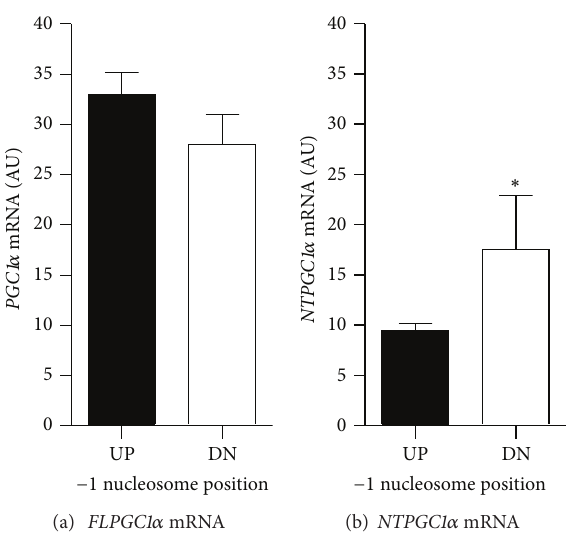
Figure 2: PGC1 𝛼 gene expression. mRNA expression of FLPGC1 𝛼 (a) and NTPGC1 𝛼 (b) was measured by qRT-PCR in quadriceps muscle samples and mean ± SEM is shown as arbitrary units (AU) in upstream (UP, black) and downstream (DN, white) individuals. ∗ indicates significant difference between groups by Student’s 𝑡 -test with 𝑃 < 0.05